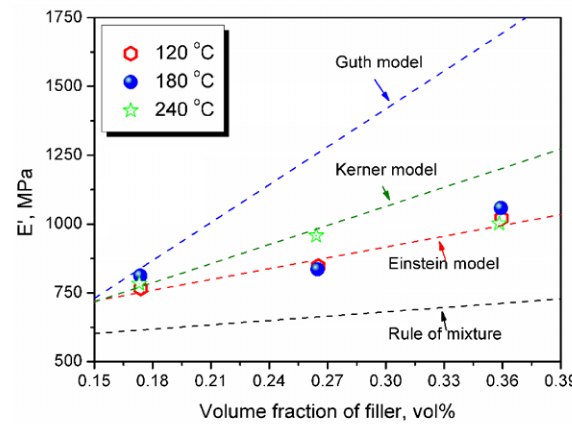
Figure 8. Experimental and predicted values of storage modulus for prepared